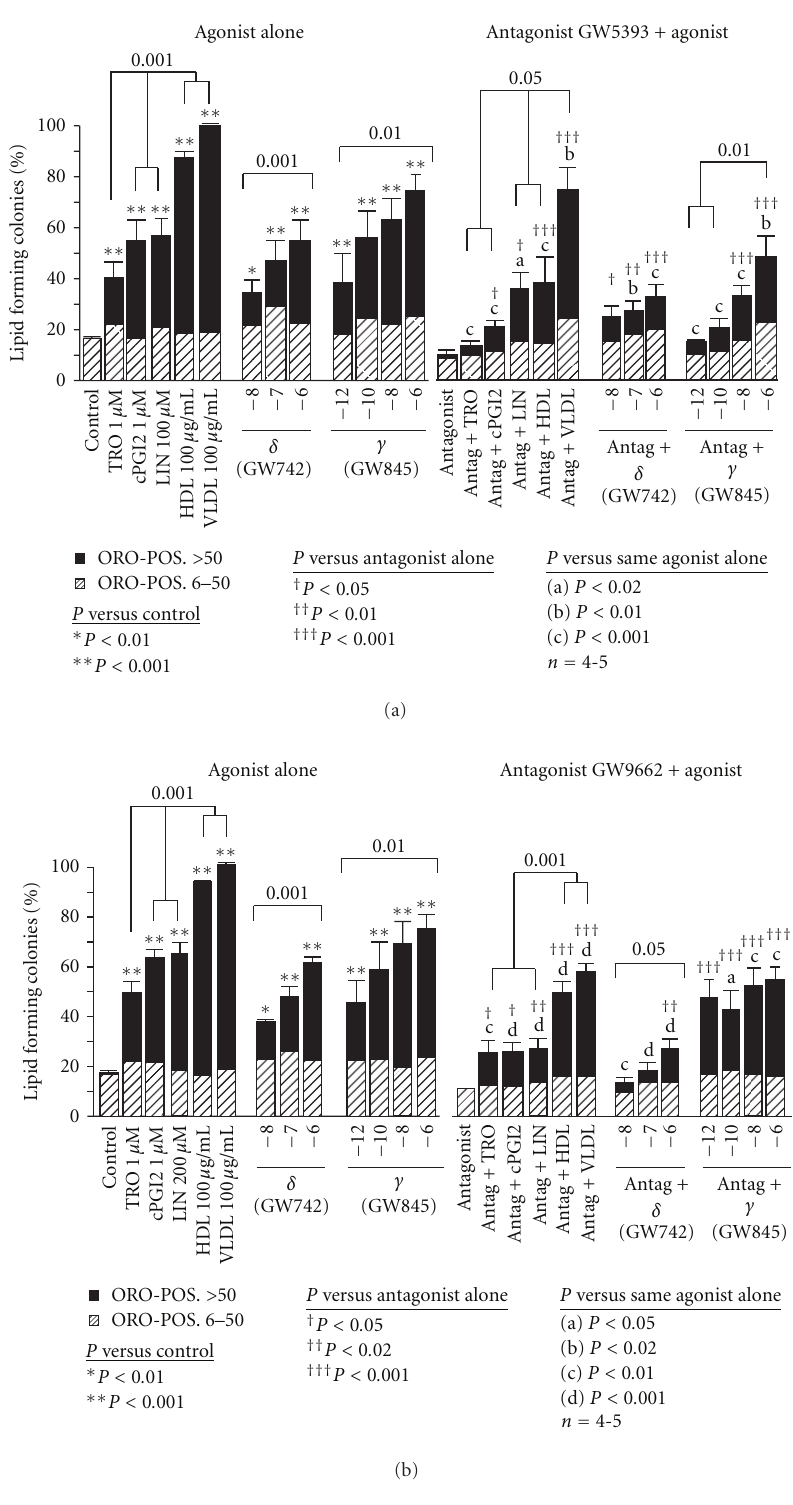
Figure 1: Comparison of sebocyte di ff erentiation induced by PPAR agonists and lipoproteins before and after pretreatment with two PPAR antagonists. Maximally e ff ective doses of the selective PPAR agonists troglitazone (TRO), carbaprostacyclin (cPGI2), and linoleic acid (LIN) were used as indicated. HDL and LDL were used at 100 μ g protein/mL. The specific PPAR δ (GW742) and PPAR γ (GW845) agonists were used at the doses indicated. The PPAR γ antagonist GW5393 (a) and the PPAR binding pocket antagonist GW9662 (b) were added to the cells at a dose of 1 μ g 2 hours prior to treatment with the PPAR agonists or lipoproteins on day 7 of primary culture. LFC determination was made on day 9 of culture after fixing and staining the cells with Oil Red O (ORO). Striped bars indicate colonies with 6–50 ORO-stained cells, and solid bars those colonies with > 50 ORO-stained cells. Means +/ − SEMs are